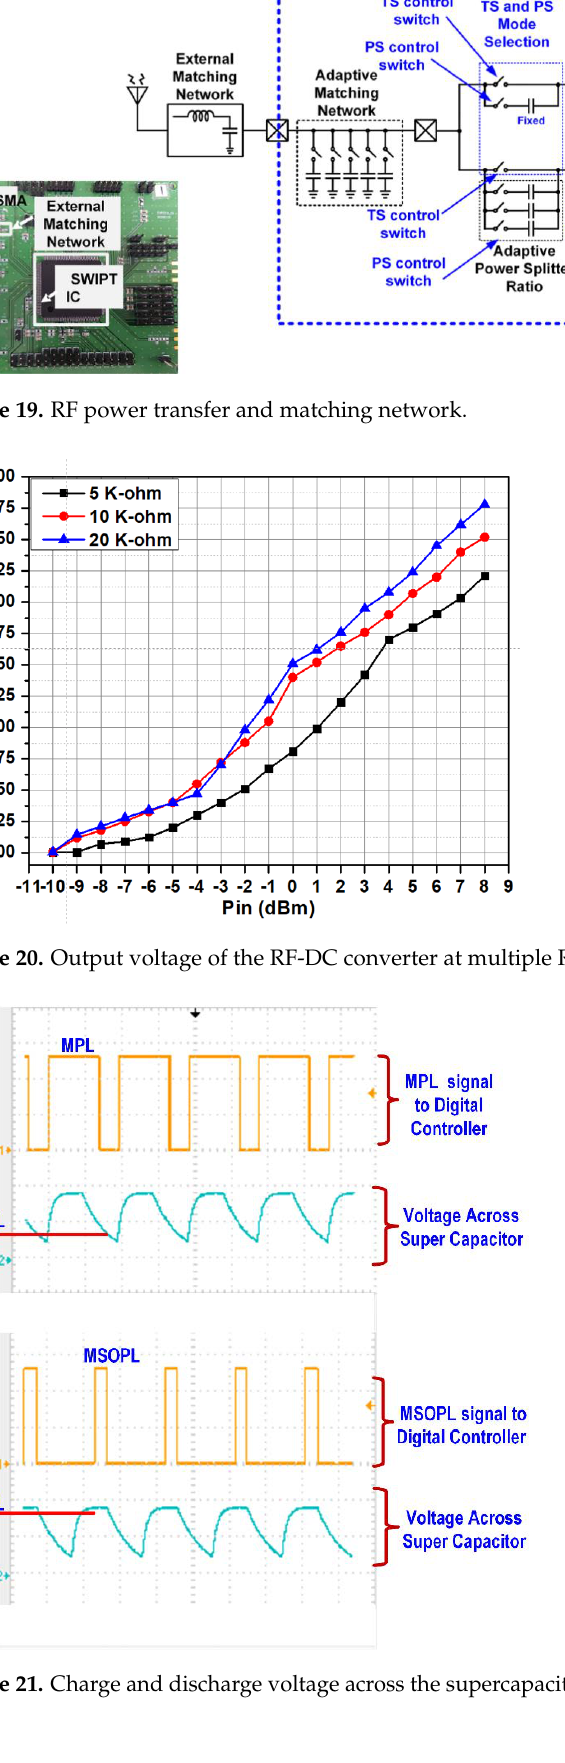
Figure 22. The RF 2-ASK and 4-ASK modulated SSF frame at 5.8 GHz. Figure 23. Data communication between the SWIPT transmitter and SWIPT receiver with a time switching scheme.